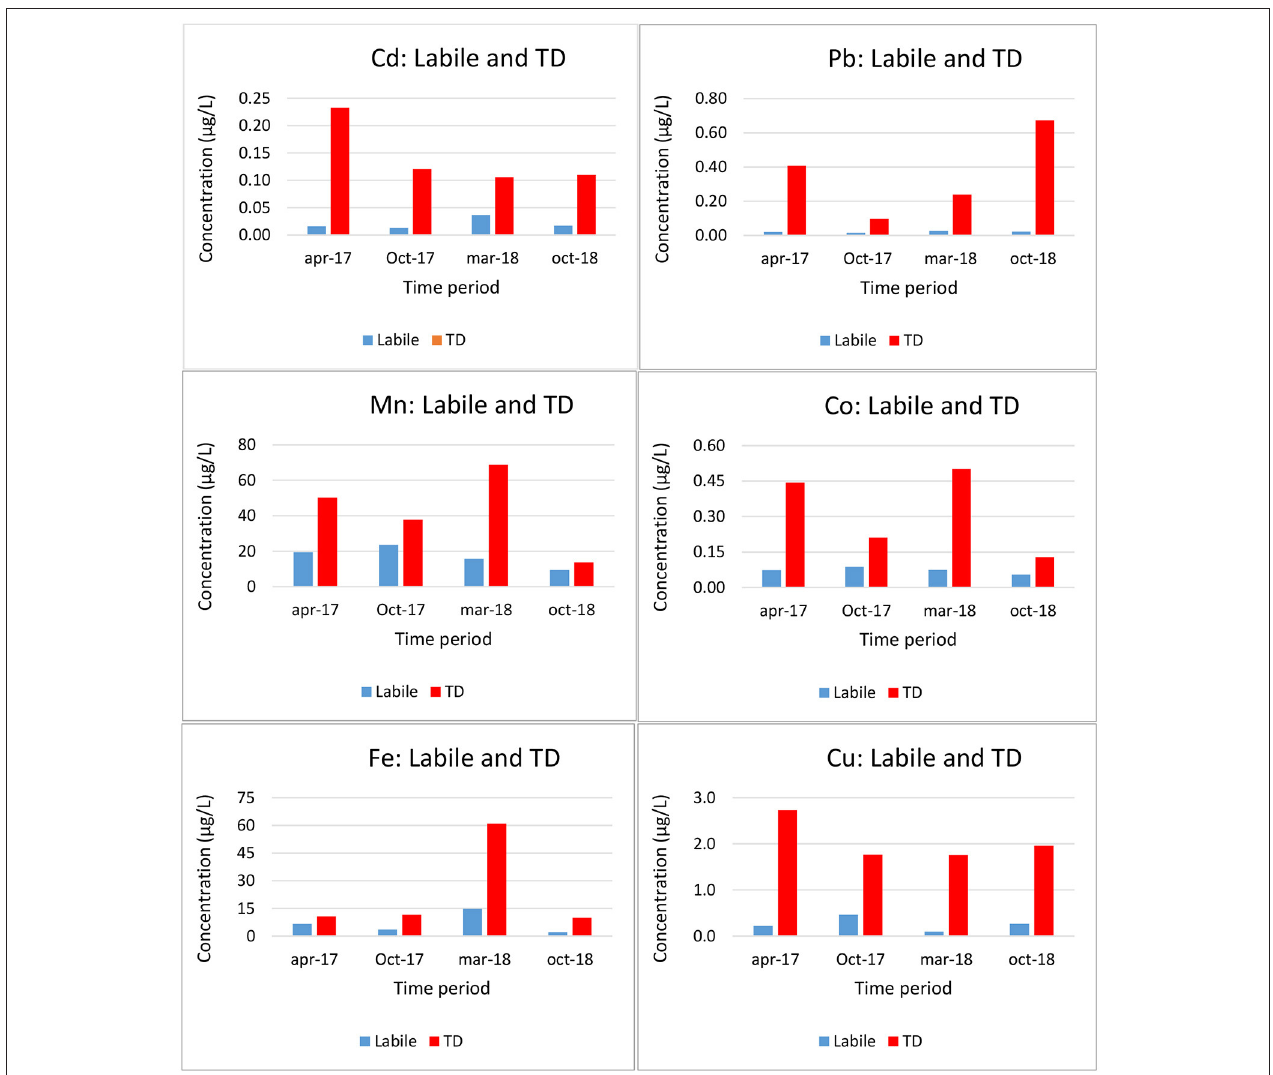
FIGURE 3 | Total dissolved (TD) and labile (DGT) trace metal concentrations at station Oostende in the Belgian Coastal Zone (Gao et al.,